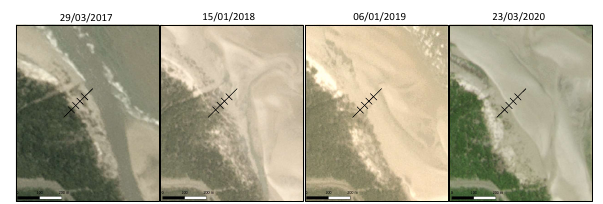
Figure 13. The optical acquisitions operated by ©Planet Labs Inc. Each acquisition shows the state of the coast at each year, but tidal level could be different for each panel. However, it is possible to appreciate the regression of the vegetated area. The black transect with the gridded bar is the same one that was on Figure 12, so that a comparison with the SAR analysis is